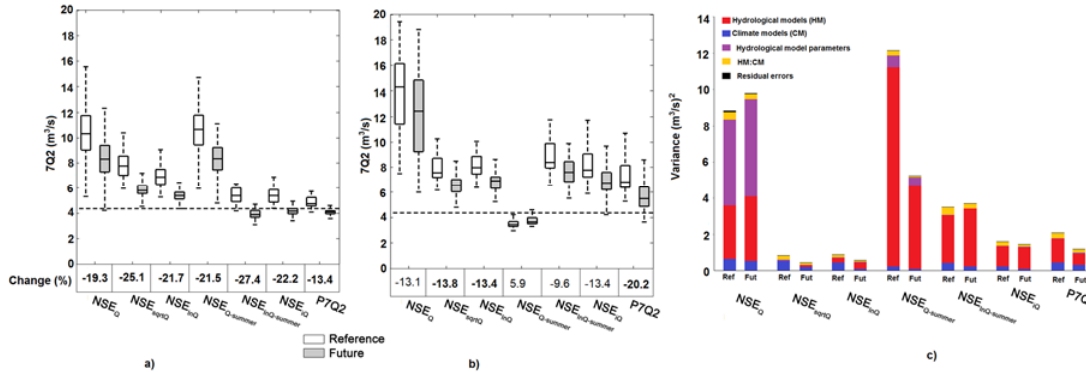
Figure 9. Uncertainties for the 7Q2 indices for the St-Hyacinthe sub-watershed related to the climate model structure for the ( a ) GR4J; and ( b ) SWAT model; and ( c ) comparison of 7Q2 index variance for each source of uncertainty in reference (Ref) and future (Fut) periods for each objective functions.